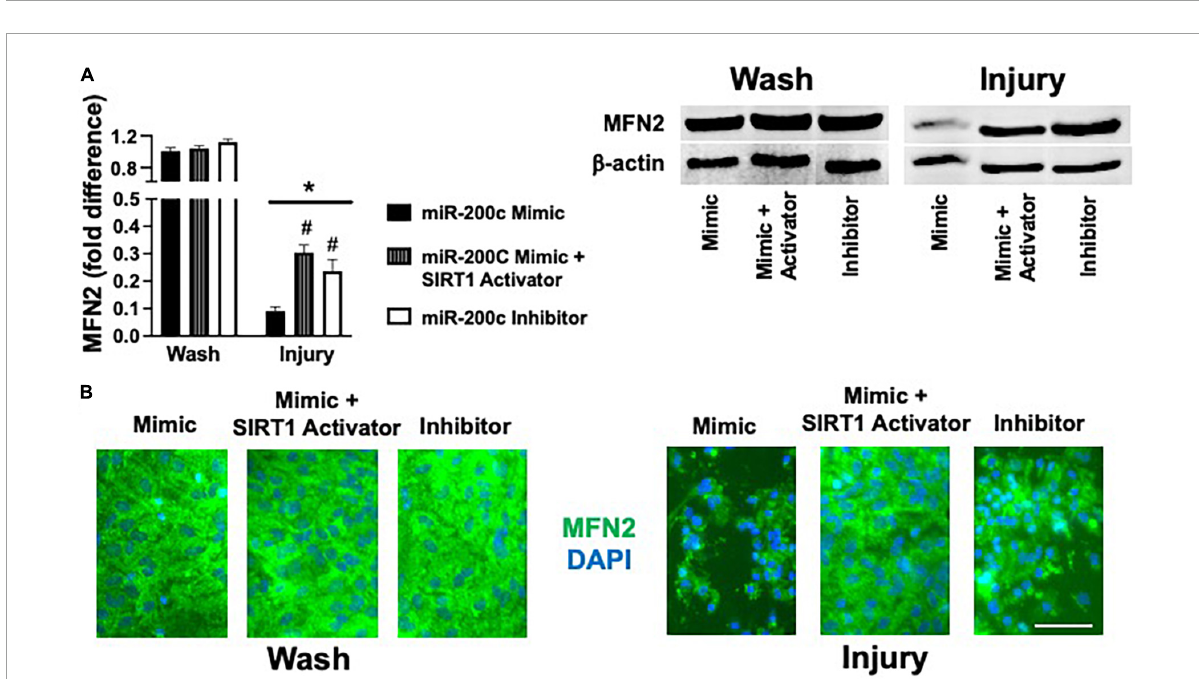
FIGURE8 Effect of miR-200c and SIRT1 activation on pre- and post-injury astrocyte MFN2 expression in astrocyte cultures. Quantification (A) and representative images (B) of MFN2 fluorescence 24 h after 3 h combined oxygen glucose deprivation injury in primary cortical astrocyte cultures with miR-200c mimic, miR-200c mimic + SIRT1 activator YK 3-237, or miR-200c inhibitor pre-treatment. N = 3 independent cultures, mean + SEM, * p < 0.05 versus within treatment wash control and # p < 0.05 versus mimic injury. Scale bar, 15 µ